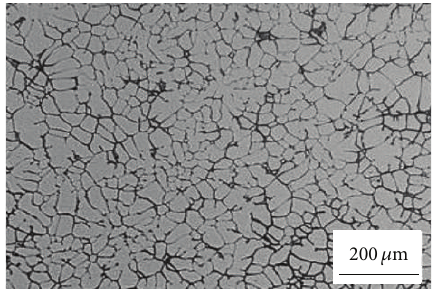
Figure 27: Microstructure of A2017 aluminum alloy obtained by SCR process [55].